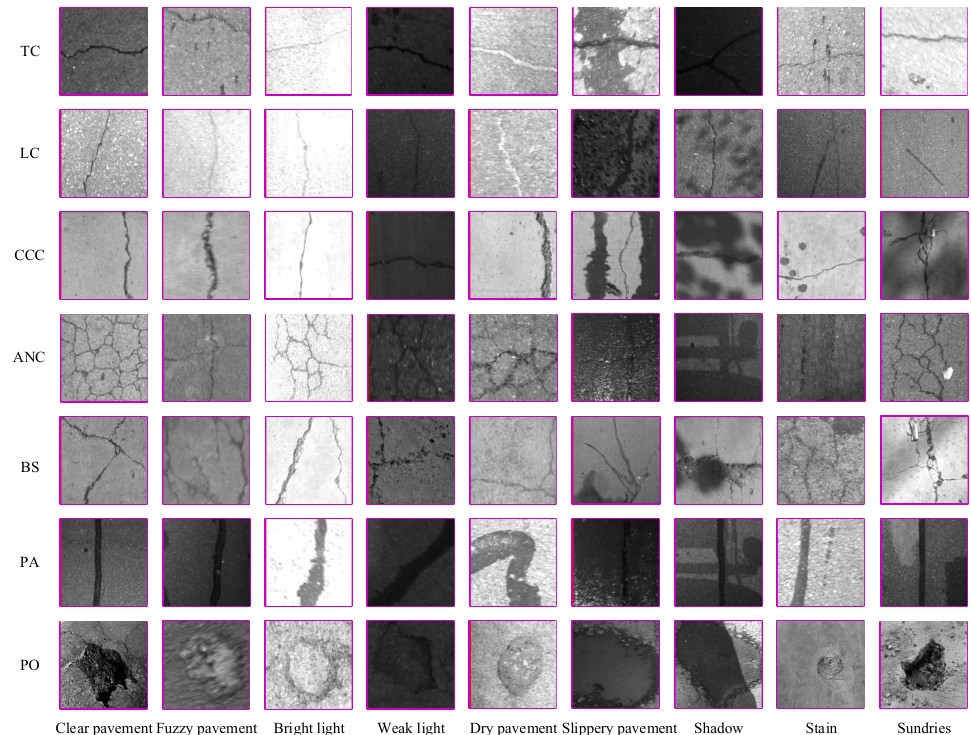
Figure 4. Samples from the ISTD-PDS7 dataset: nine scenes of each distress class are shown. There are 6533 images within seven classes.